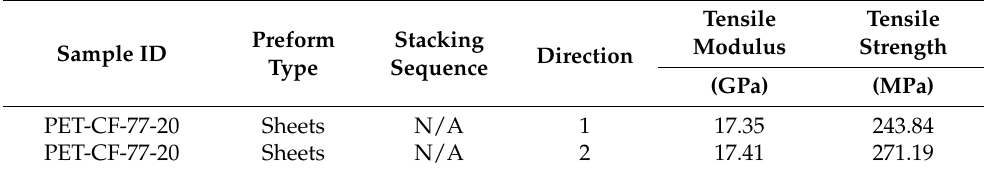
Table 9. Tensile modulus and strength—C/PET (preform